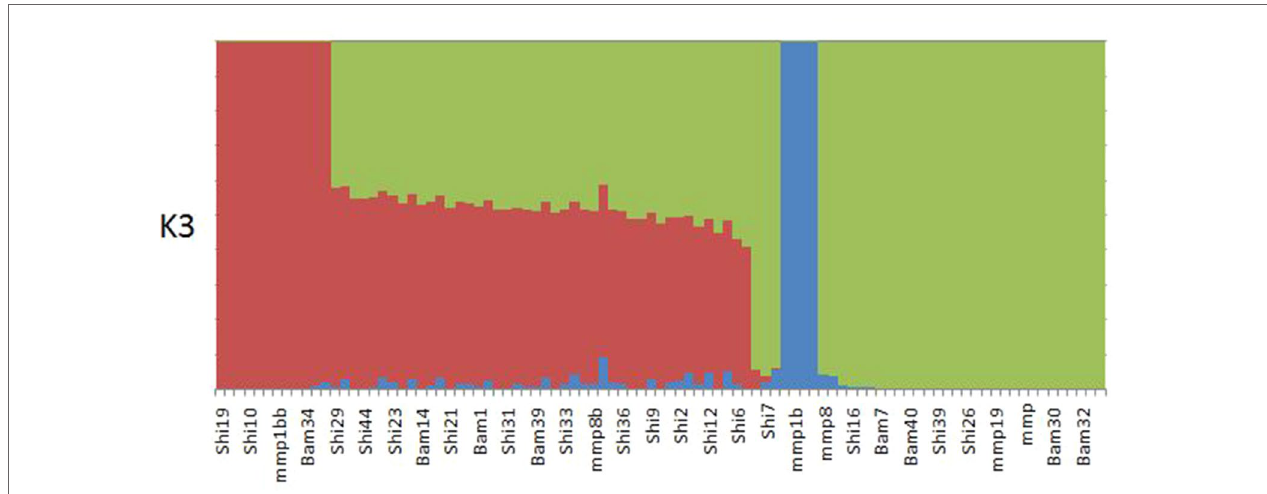
FIGURE 2 | ADMIXTURE plot for K3 showing structuring of samples collected from Bamburi (Bam), Shimoni (Shi), and Mombasa Marine Park (MMP) in coastal Kenya; colors represent different populations.